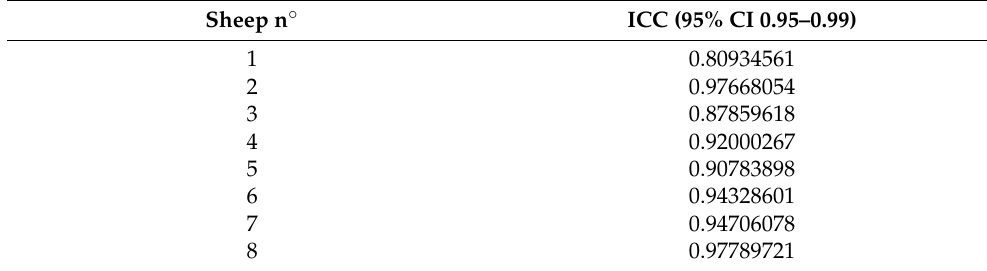
Table 2. Interobserver